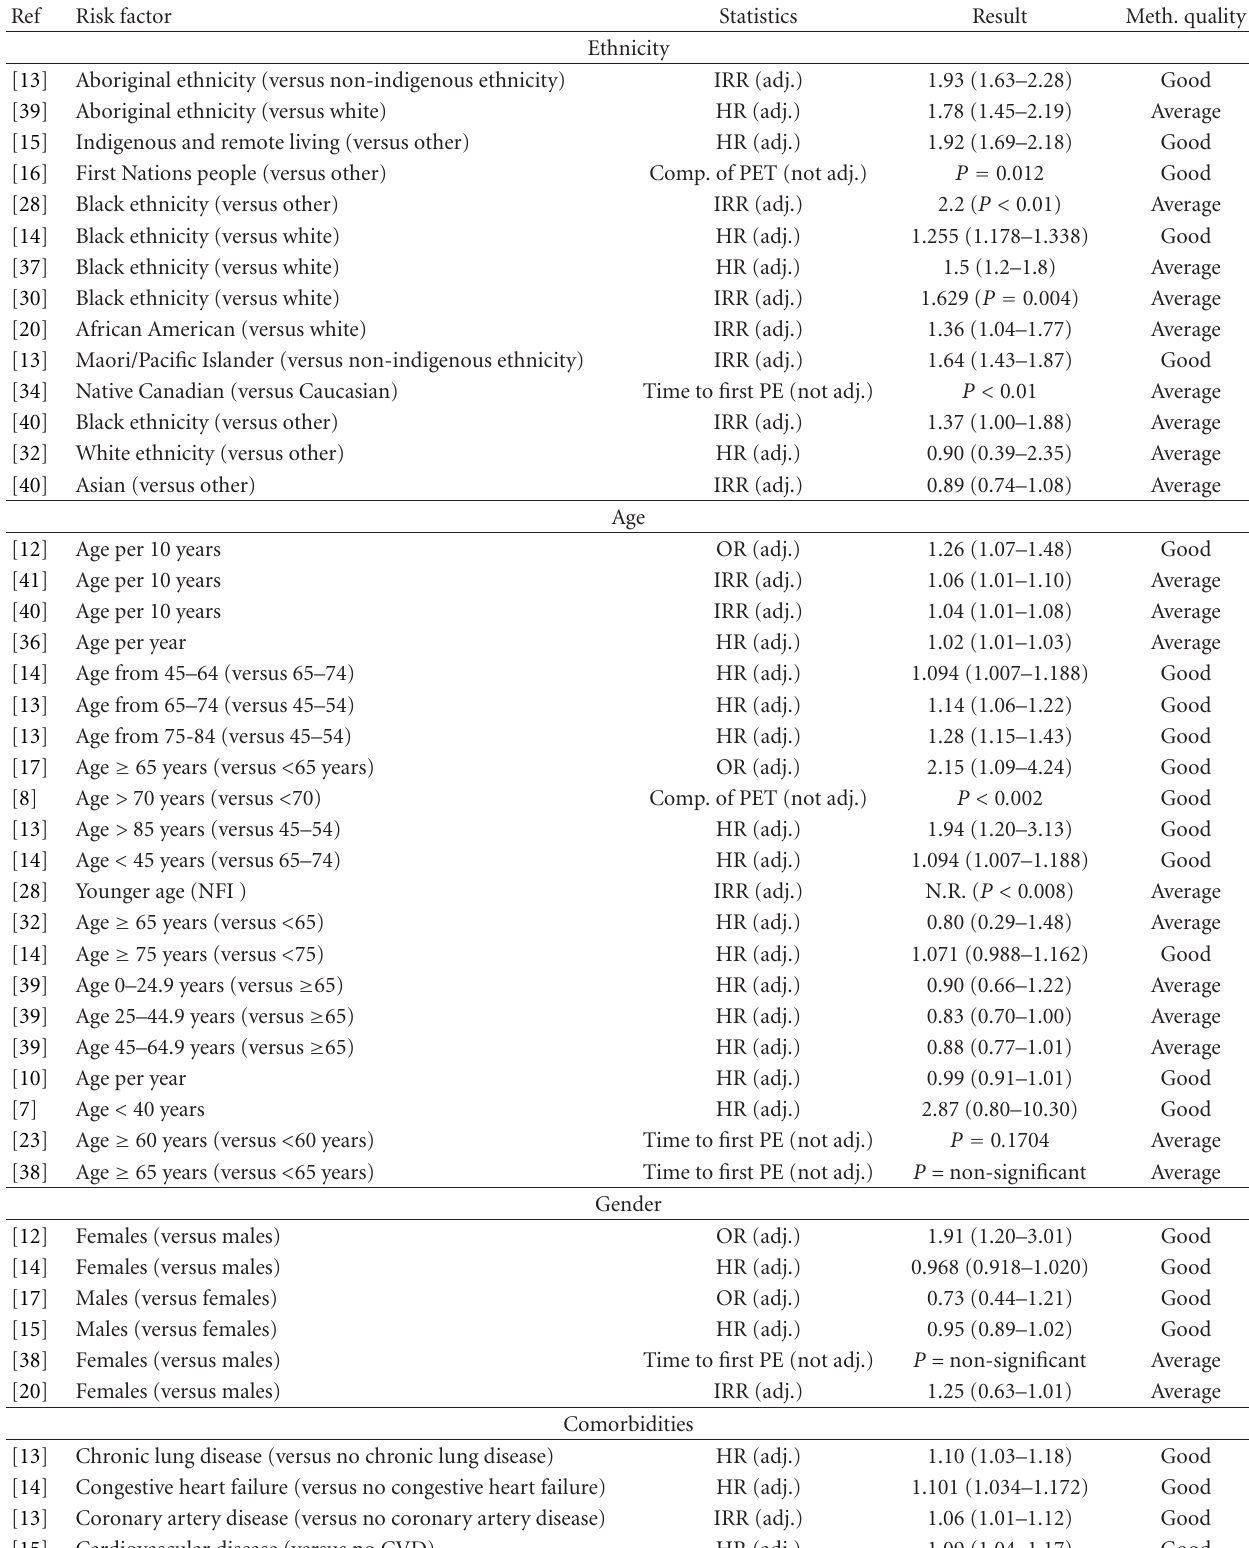
Table 3: Identified non-modifiable risk